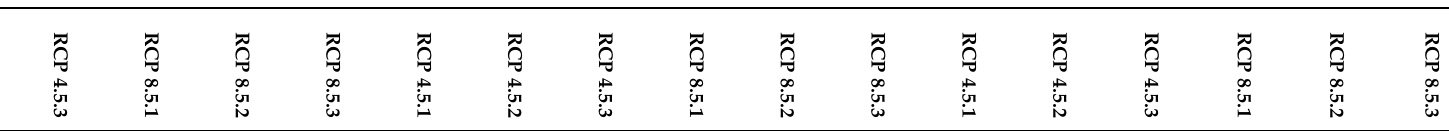
Table 10. Comparison of the average monthly total runoff for the SWAT simulation period 2010–2017 with individual projections for the RCP 4.5 and RCP 8.5